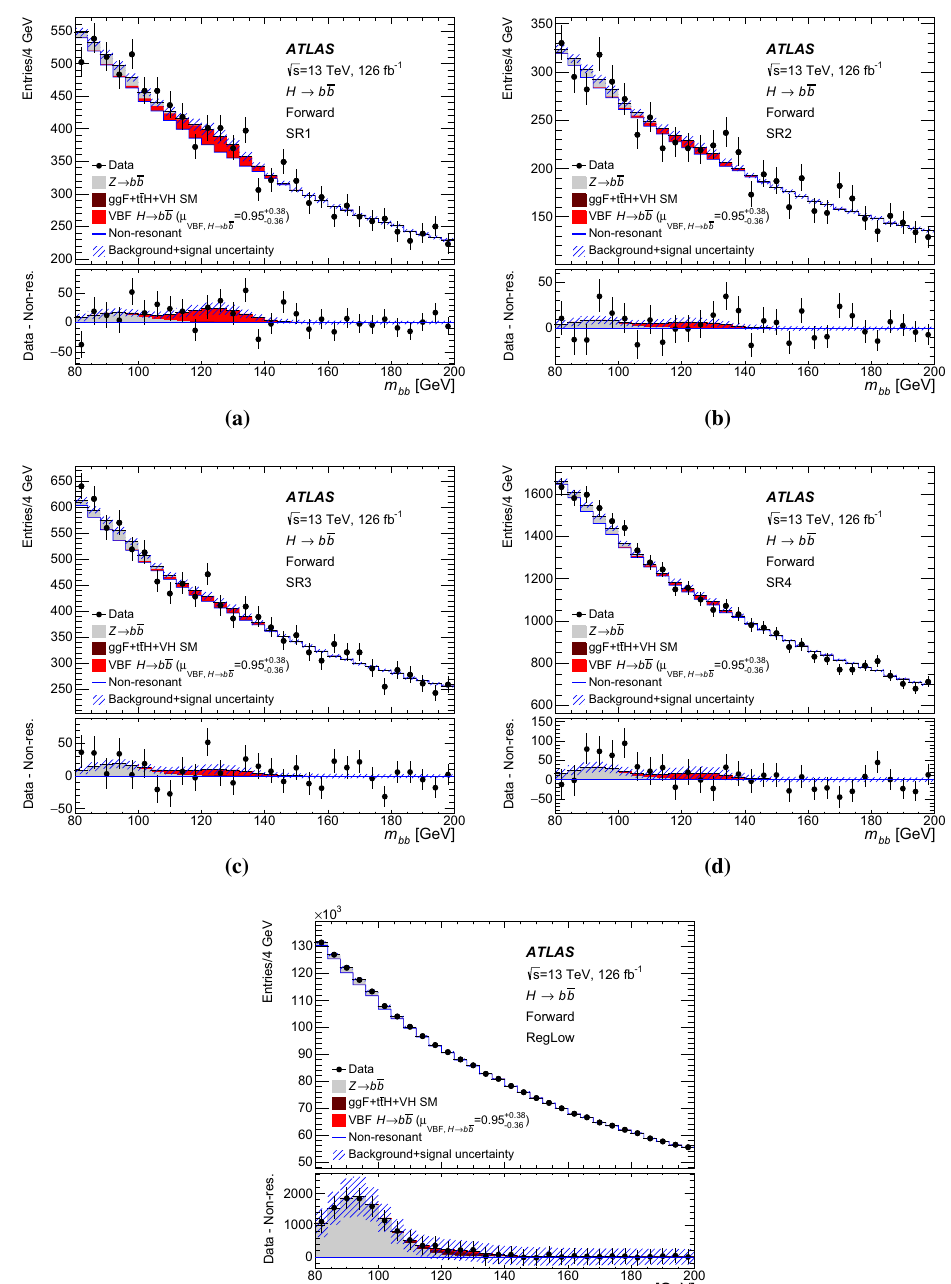
Fig. 4 Fit results for the Forward channel. Top left is SR1, top right is SR2, middle left is SR3, middle right is SR4, bottom is RegLow. The data are the black points, the blue line is the non-resonant background shape (continuum), grey is the resonant background ( Z → b ¯ b ), red is the fitted VBF Higgs boson signal (VBF H → b ¯ b ), and maroon are events attributed to the other Higgs boson production mechanisms (ggF + t ¯ tH + V H ). The bottom panel of each plot shows the difference